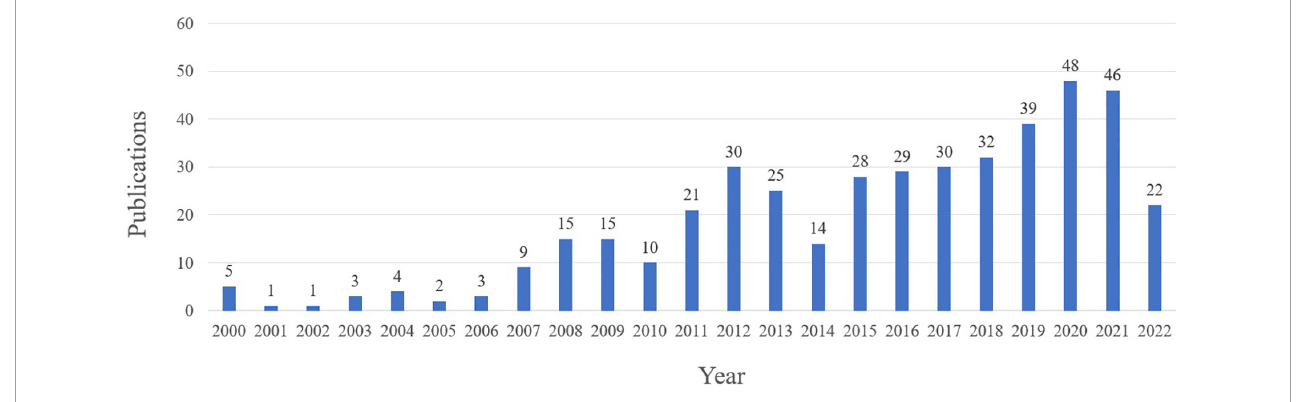
FIGURE2 The number of annual publications on traditional Chinese exercises for musculoskeletal disorders research from 2000 to 2022.